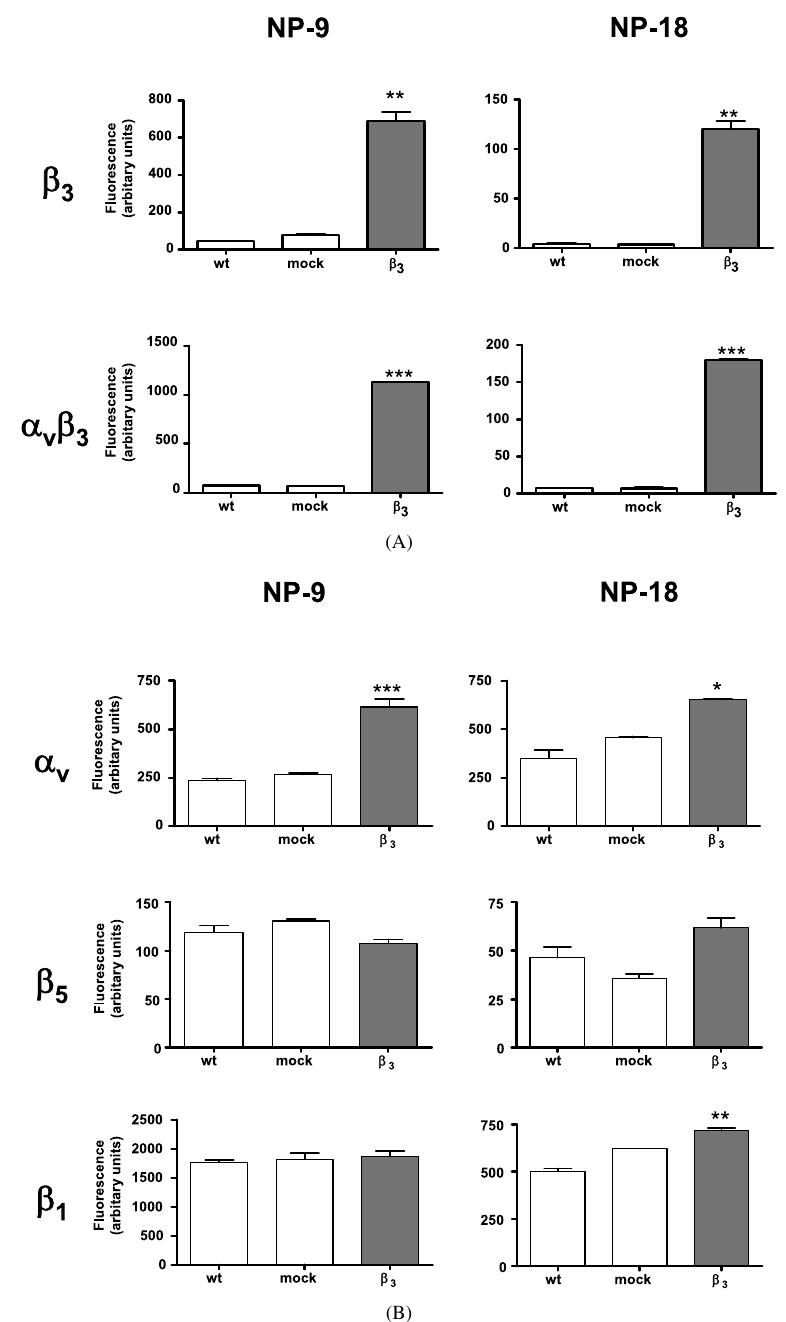
Fig. 1. Membrane presence of several integrin subunits and α v β 3 in NP-9 and NP-18 cell models. Cells were incubated with mAbs against β 3 (AP-3), α v β 3 (LM609), α v (17E6), β 5 (P1F6) and β 1 (P4C10), followed by staining with FITC-conjugated rabbit anti-mouse Ig antibody, and analyzed using an Epics-XL flow cytometer. Bars depict fluorescence intensity for the different cell lines (wt: parental, mock: mock-transfected and β 3 : β 3 -transfected). Means ± SD fluorescence units of three independent experiments are shown. Statistics: t -test, * p (cid:2) 0 . 05, ** p (cid:2) 0 . 01, *** p (cid:2) 0 . 001 vs.